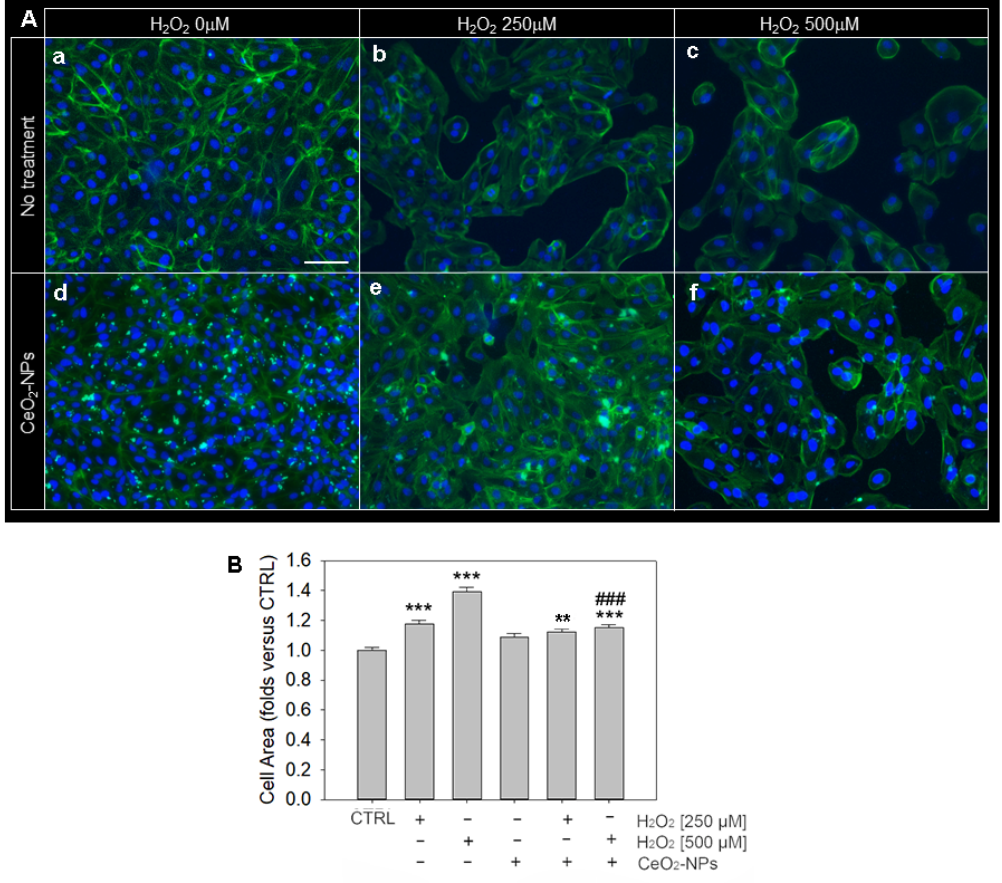
Figure 6. Phalloidin staining of ARPE-19 cells. ( A ) ARPE-19 cells stained with phalloidin (green) and bisbenzimide (blue), which label α -actin and nuclei, respectively. ( a ) Control cells; ( b ) cells exposed to 250 µ M H 2 O 2 and ( c ) 500 µ M H 2 O 2 ; ( d ) cells treated with 0.1 mM CeO 2 -NPs; ( e ) cells exposed to 250 µ M H 2 O 2 and treated with 0.1 mM CeO 2 -NPs; ( f ) cells exposed to 500 µ M H 2 O 2 and treated with CeO 2 -NPs 0.1 mM. Scale bar: 100 µ m. ( B ) The graph shows the analysis of the ARPE-19 area with six experimental conditions (control, H 2 O 2 250 µ M, 500 µ M, CeO 2 0.1 mM, H 2 O 2 250 µ M/CeO 2 0.1 mM, H 2 O 2 500 µ M/CeO 2 0.1 mM). Data are shown as mean ± SE. One-way ANOVA test followed by Tukey’s test was used to perform statistical analysis ( n = 200). ** p < 0.01; *** p < 0.001 versus